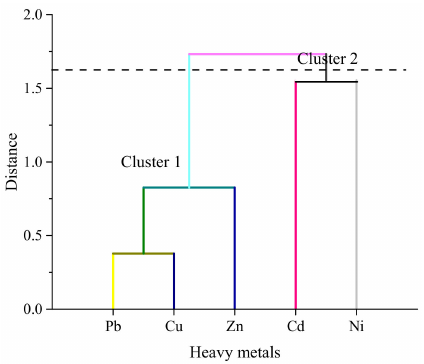
Figure 4. Hierarchical clusters (dendrogram) of the metals in the